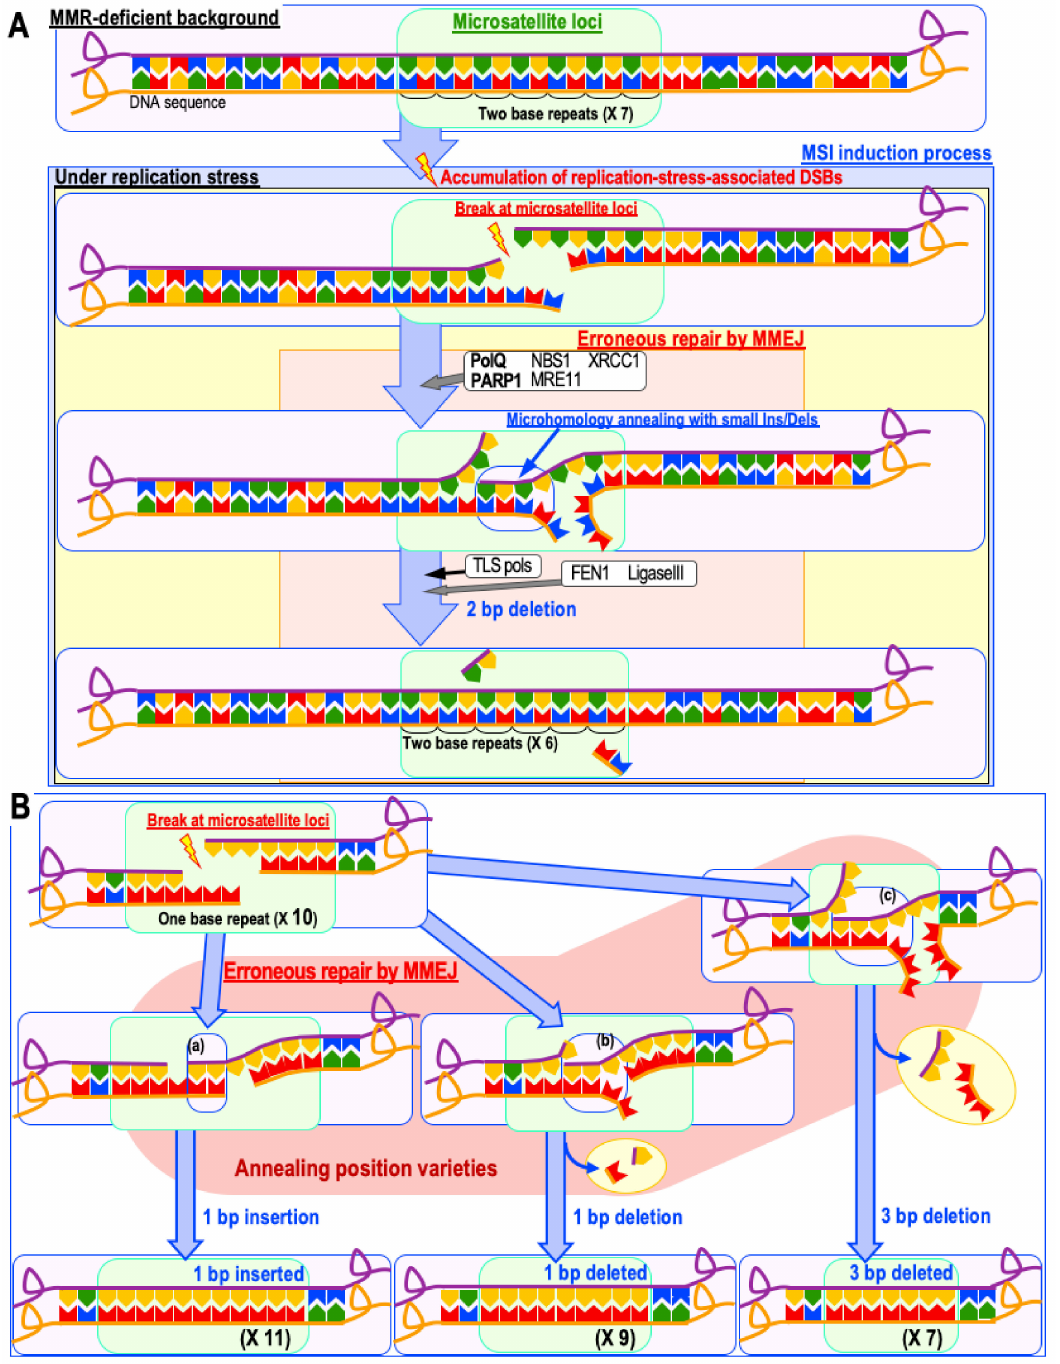
Figure 3. Model of microsatellite instability (MSI) induction. ( A , B ) Under an mismatch repair (MMR)-deficient background, double strand breaks (DSBs) caused by replication stress are e ff ectively repaired by microhomology-mediated end joining (MMEJ), which is mediated by PolQ and Poly (ADP-ribose) polymerase 1 (PARP1) ( A ). Such microsatellite loci could be repeats of a single base ( B ), two bases ( A ), or more. This induces insertions and deletions of a few bases, specifically at repetitive sequence loci (i.e., microsatellite loci), leading to MSI induction. Because microhomologies can anneal in multiple ways (a–c), this process could lead to multiple types of insertions and deletions ( B